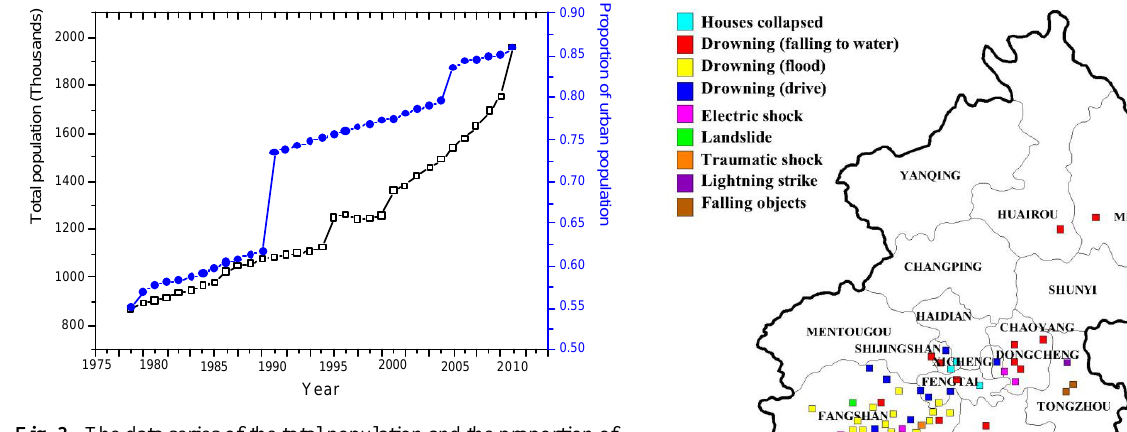
Fig. 3. The data series of the total population and the proportion of urban population in Beijing during 1978–2010.